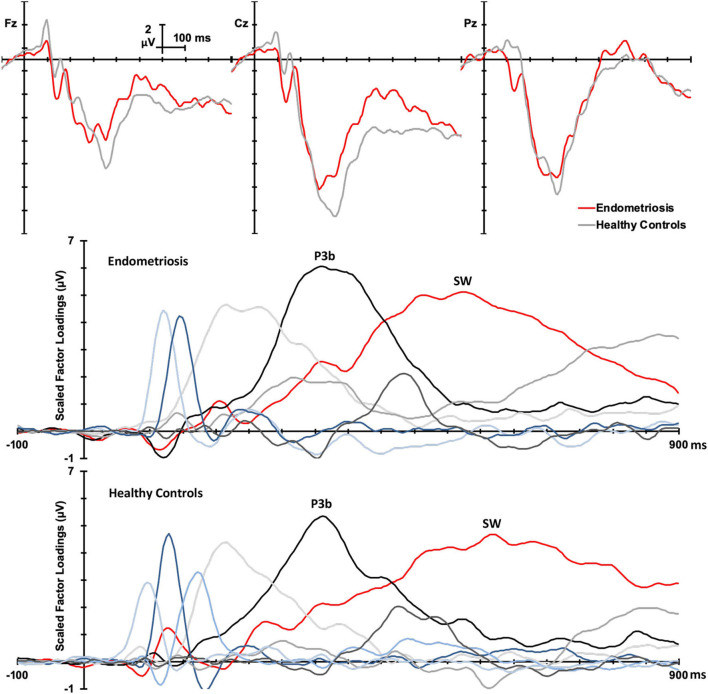
(Top) Grand mean ERPs (with negative plotted upwards) to target stimuli for the endometriosis (red) and HC (gray) groups across three midline sites (Fz, Cz, Pz). (Middle) Factor loadings for the 7 PCA components for the endometriosis group, the identified P3b (TF02) and SW (TF01) components are marked. (Bottom) Factor loadings for the 8 PCA components for the HC group; again P3b (TF02) and SW (TF01) are labeled.